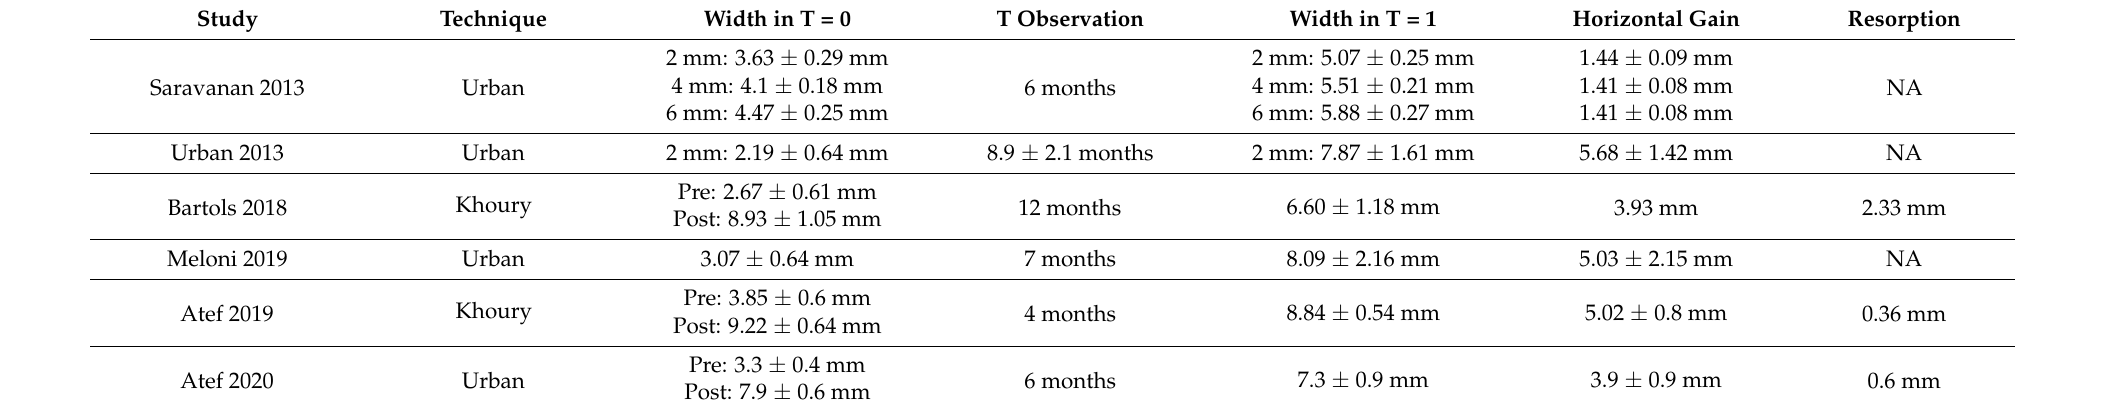
Table 3. Ridge measurements before and after augmentation. NA: Not